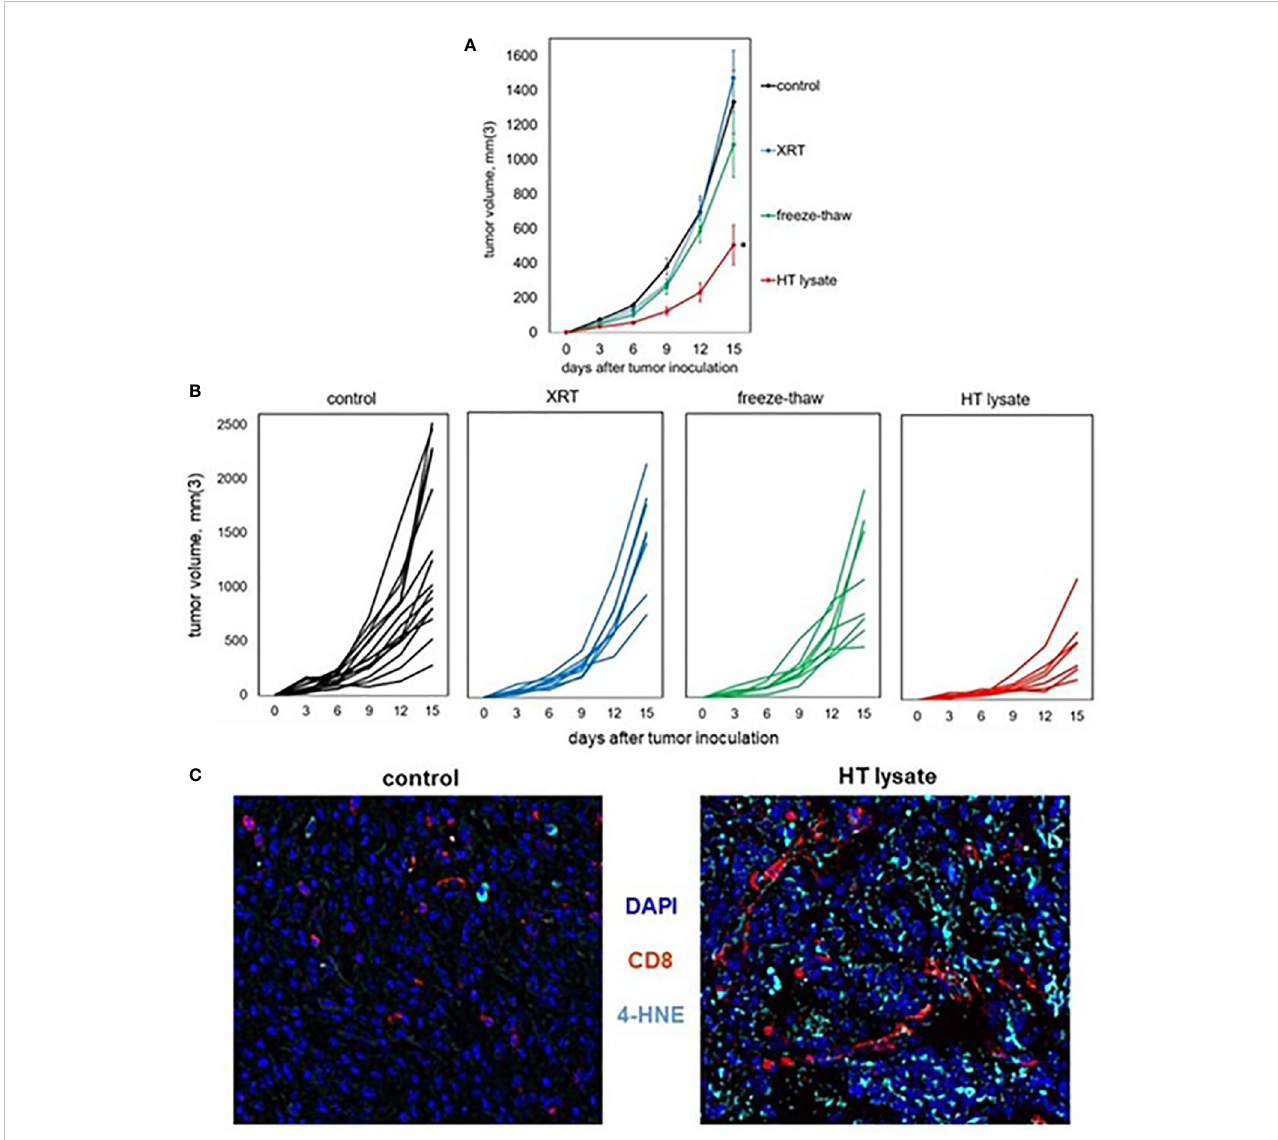
FIGURE 7 Tumor lysates generated by histotripsy confer partial protection when administered as vaccines. Mice bearing B16F10 tumors were treated with no therapy, 15 Gy radiation therapy (XRT), or histotripsy ( “ HT ” ) ablation on day 9. Tumors were explanted on day 10 and untreated tumors were dissociated by 3 cycles of alternative freezing and thawing. The resulting lysates were centrifuged to generate cell-free fractions, and fractions were delivered via intraperitoneal injection into naïve mice one day prior to B16F10 fl ank injection. (A, B) Whereas vaccination with tumor lysates generated by XRT or freeze-thaw conferred no protection against B16F10 challenge tumor growth as compared with unvaccinated controls, mice receiving tumor lysates generated by histotripsy exhibited slower challenge tumor growth kinetics. (C) Multicolor immunohistochemistry of challenge tumors growing in unvaccinated control and HT lysate-vaccinated mice showed marked increases in both CD8+ cell in fi ltration and 4-HNE accumulation. (n=3-6 mice per group; *=p<0.05 compared with